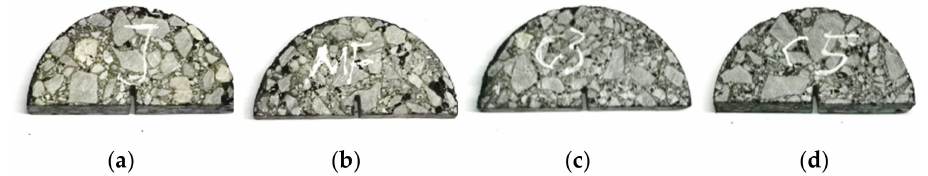
Figure 1. Specimens under low-temperature performance test (SCB test): ( a ) common